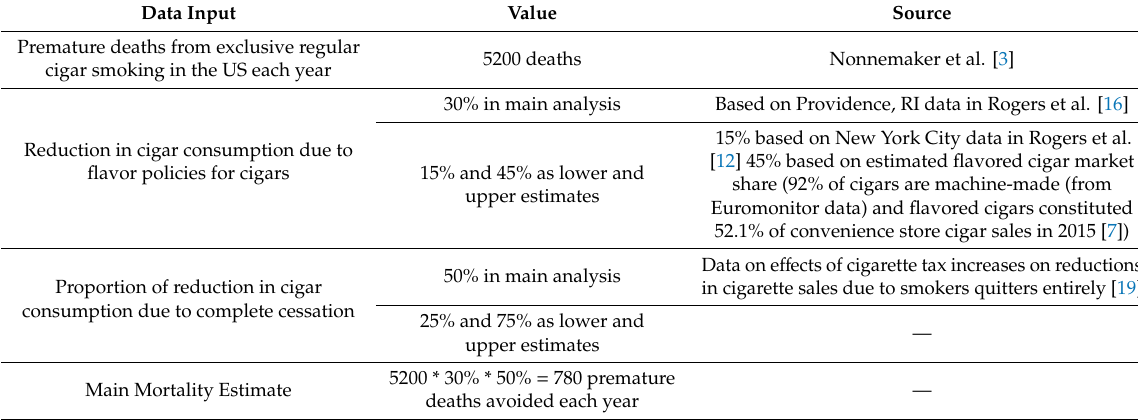
Table 1. Data inputs used to estimate the potential number of cigar attributable deaths prevented by policies prohibiting flavored cigars throughout the